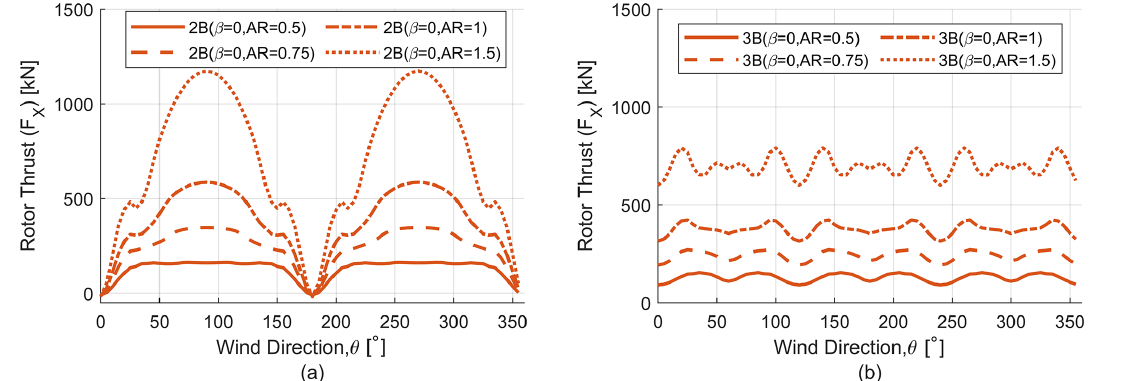
Figure 22. Parked rotor thrust load ( F X ) analysis for different aspect ratio (AR) rotors. (a) Parked thrust load ( F X ) for two-bladed (2B) rotors. (b) Parked thrust load ( F X ) for three-bladed (3B) rotors.